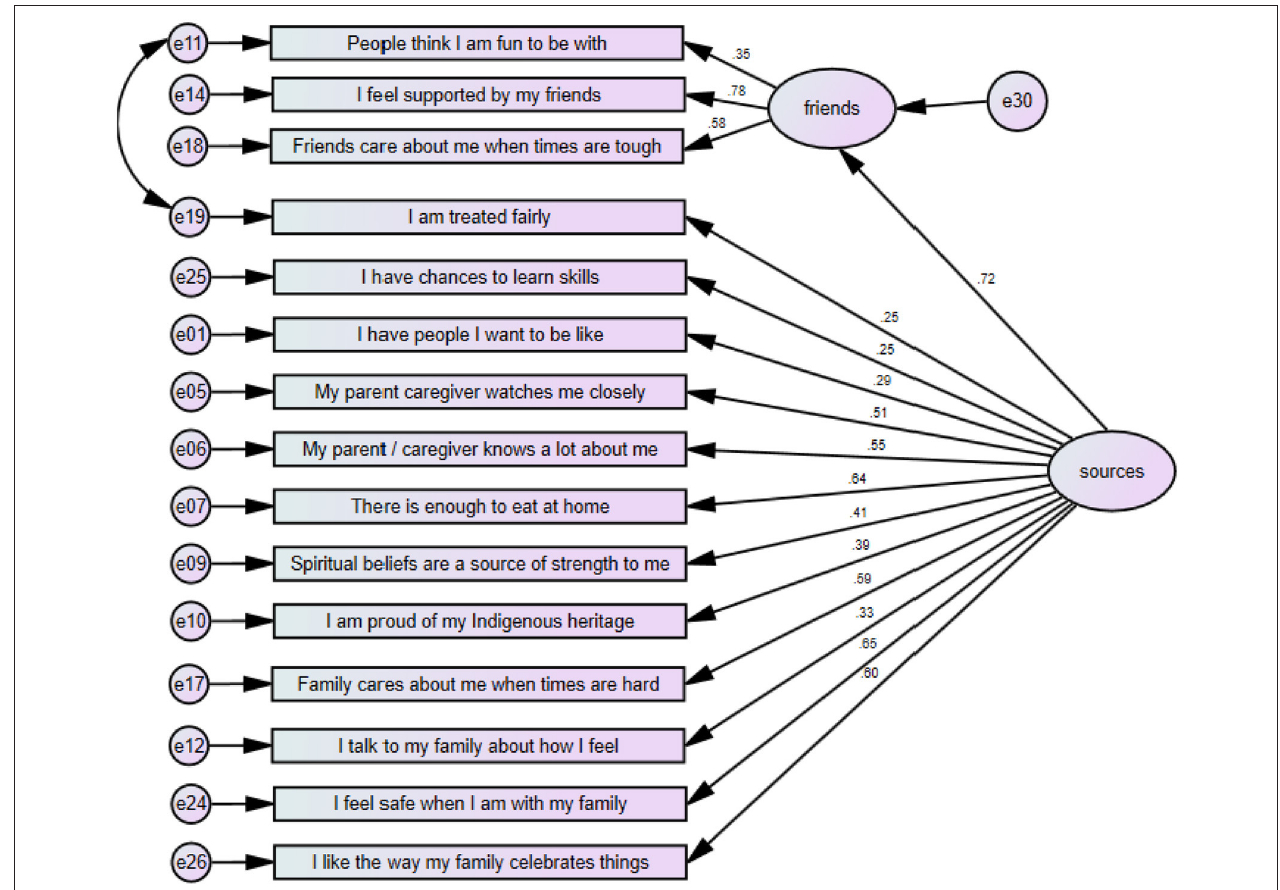
FIGURE 1 | Sources of Resilience Model including standardized item